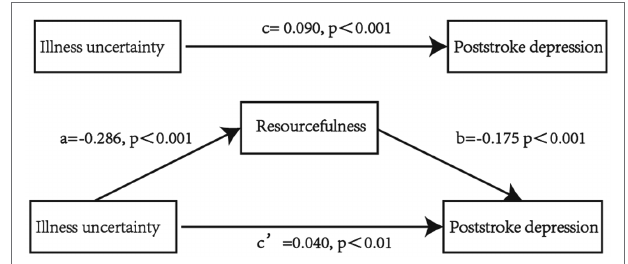
FIGURE 1 | Mediating effect of resourcefulness between illness uncertainty and poststroke depression (PSD). All path coefficient was unstandardized. c Path illness uncertainty—PSD (total effect). a * b Path (indirect effect) and c’ Path (direct effect) accounted for 55.56% and 44.44% of the c Path (total effect),